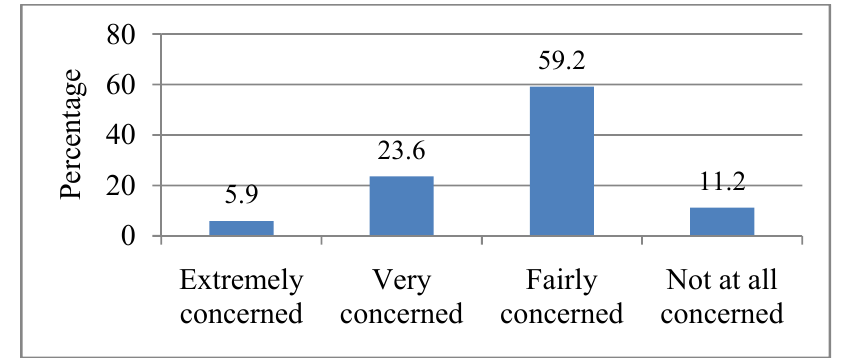
Figure 6. Extent of respondents’ societal concern on the impacts of heat waves. Q6. How concerned are you about the effects of heat waves to